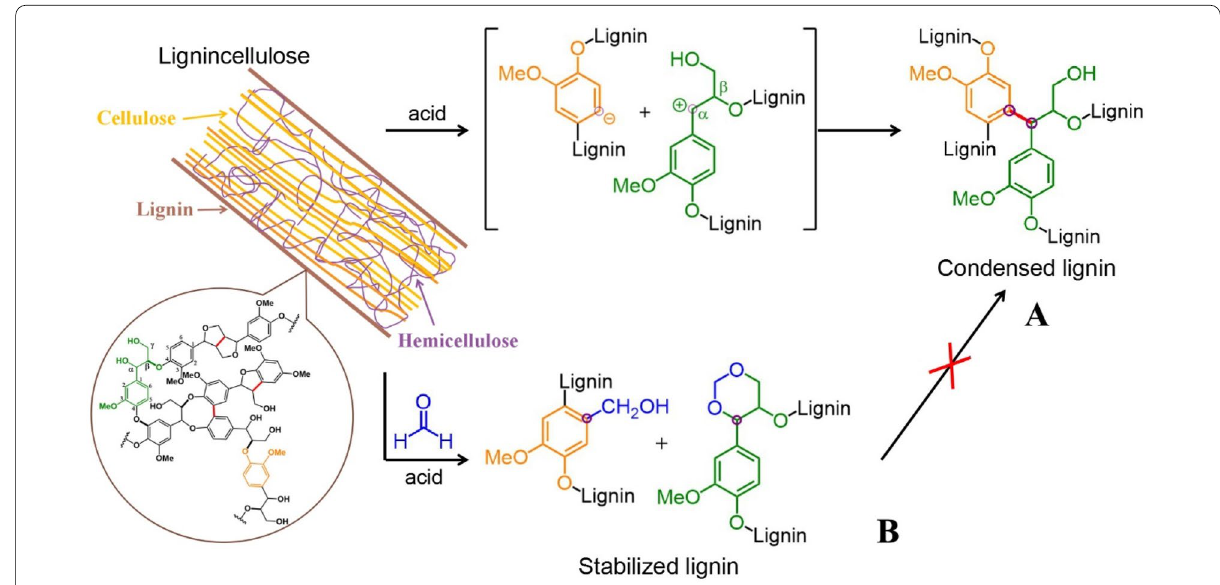
Fig. 1 Condensation mechanism of lignin ( A ) and mechanism of formaldehyde preventing polymerization ( B